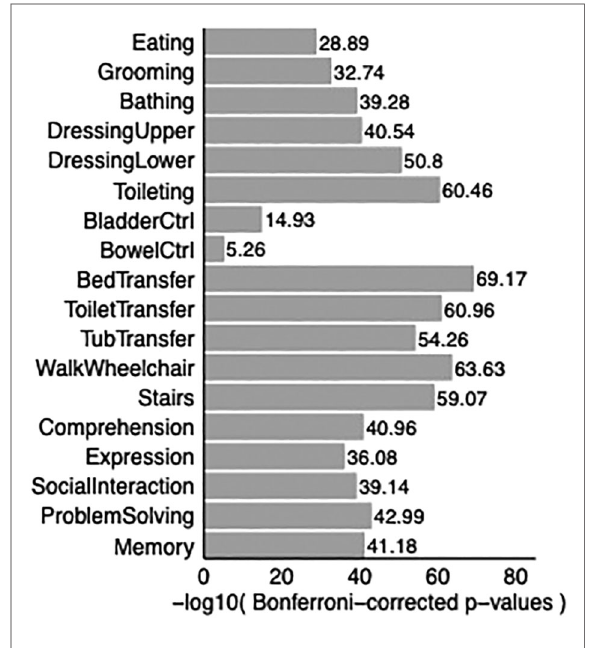
FIGURE 3 Bar graph shows p -values comparing FIM scores at discharge with FIM scores at admission. P -values are adjusted for multiple correction. All p -values are smaller than 0.05, showing improvement in all 18 Functional Independence Measurement (FIM) items upon discharge in TBI patients compared to admission to acute